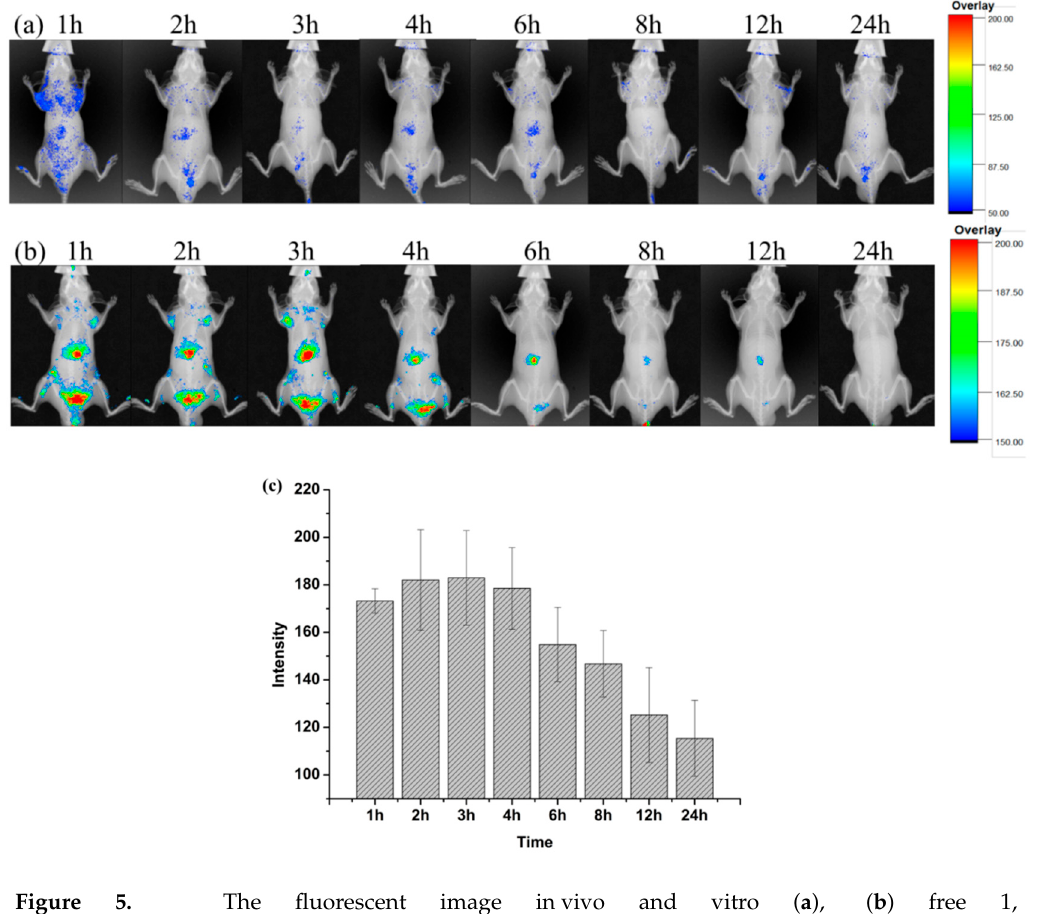
Figure 5. The fluorescent image in vivo and vitro ( a ), ( b ) free 1, 1 ′ -dioctadecyl-3,3,3 ′ ,3 ′ -tetramethylindocarbocyanine iodide (DiR)-solution and DiR-liposome in vivo NIR fluorescence imaging at the designated times post injection, ( c ) The fluorescent intensity at different time points corresponding with ( b ), (Values represent mean ± SD of 3 animals.).